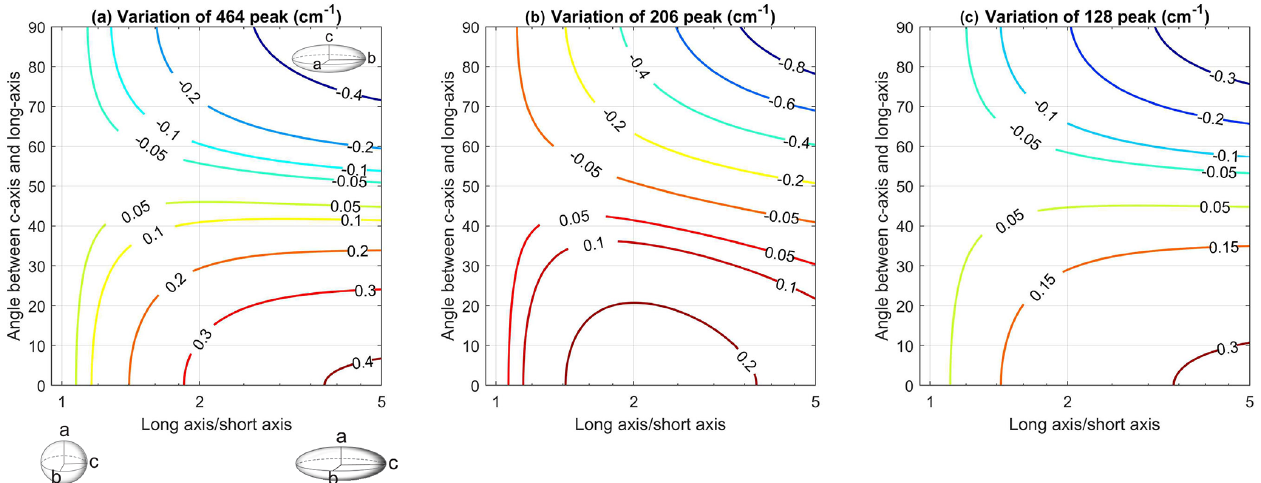
Figure 5. The effect of varying the crystallographic orientation ( c axis) with respect to the geometrical long axis of a prolate spheroidal quartz inclusion. The contours show the variation of wavenumber shift compared to perfectly spherical quartz inclusion c/a = 1 (in this case the crystallographic orientation does not matter). The horizontal axis represents the aspect ratio of the spheroidal inclusion, and the vertical axis shows the angle between the crystallographic c axis and the geometrical long axis. In the plot, c axis is allowed to shift from parallel to the geometrical long axis to parallel to the geometrical short axis of the spheroidal inclusion. The driving eigenstrain is set to produce a hydrostatic residual pressure of 1GPa in the reference spherical